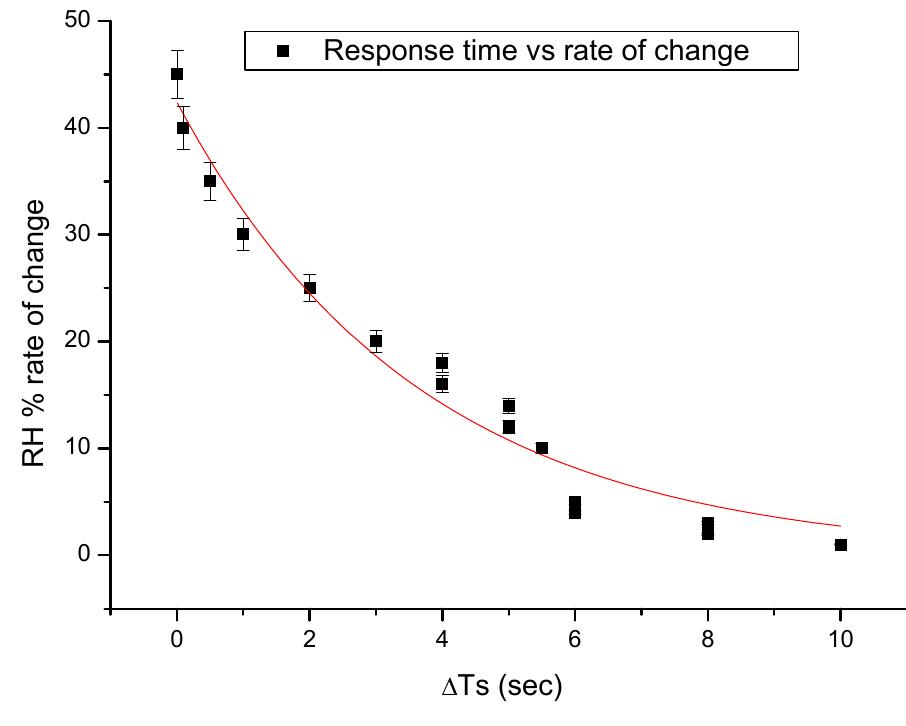
Figure 2. Graph indicating the dependence of the dimensional response time on the rate of RH change/ % RH.s -1 . As the rate of change of RH increases, the response time of the sample which is required for the observation of dimensional changes decreases, indicating the need for more rapid acquisition